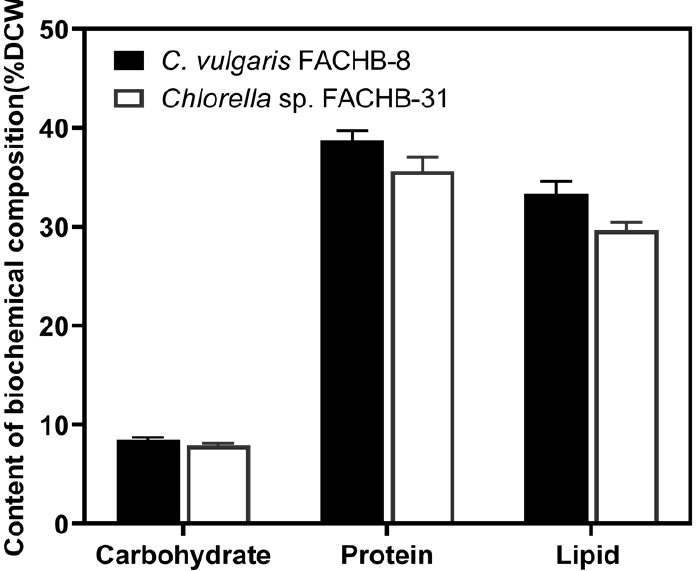
Figure 4. Comparison of content of carbohydrate, protein, and total lipid from FACHB-8 and FACHB-31 after 15 days of cultivation in undiluted ADSW. Error bars represent SD ( n = 3).